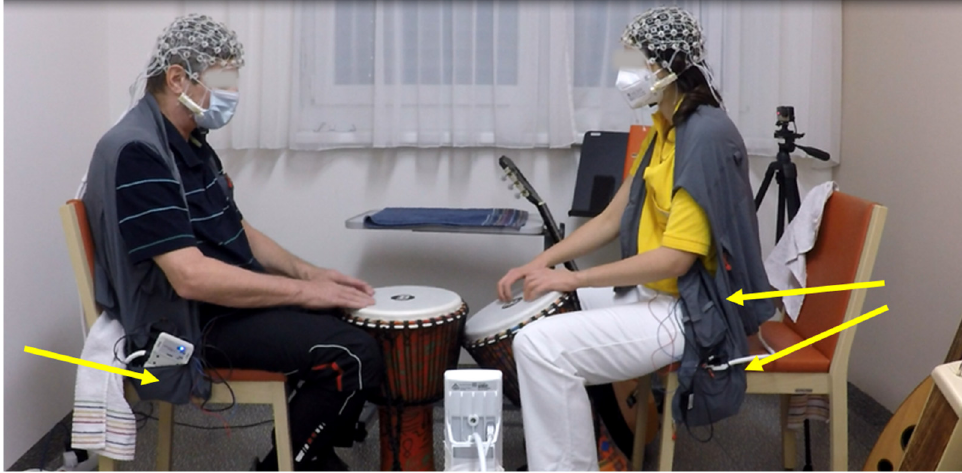
Figure 3. Patient and therapist wearing the Fisherman’s vests. The yellow arrows point to the respective pockets in which equipment was stowed.